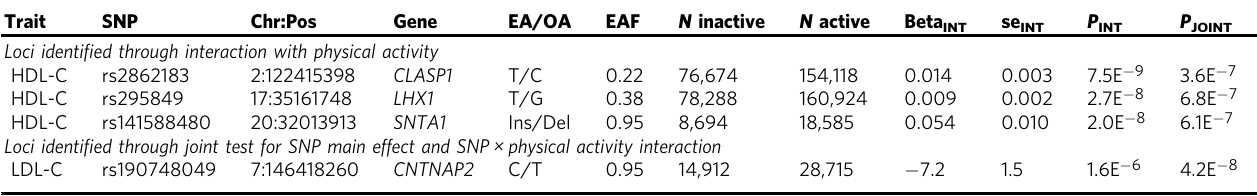
Table 1 Lipid loci identi fi ed through interaction with physical activity ( P INT < 5 × 10 − 8 ) or through joint test for SNP main effect and SNP × physical activity interaction ( P JOINT < 5 × 10 − 8 )